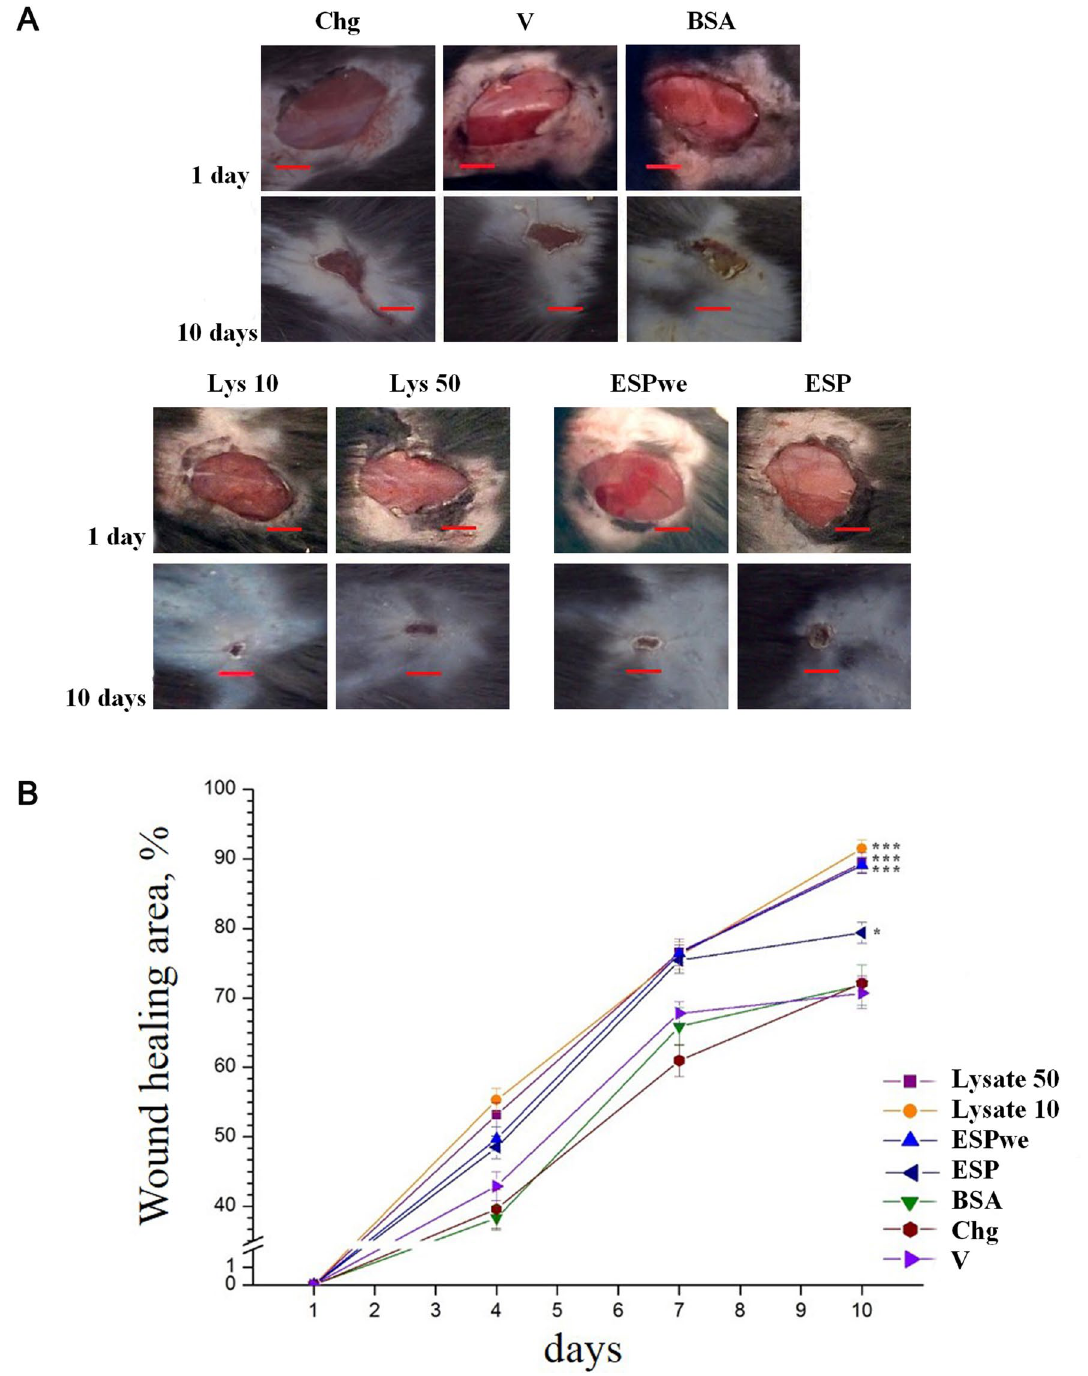
Figure 1. Visual scoring of wound healing. ( A ) Wound healing on days 1 and 10 after treatment. Wounded untreated, vehicle and nonspecific control and specific treatment groups (3 mm scale bar); ( B ) Wound healing rate chart. Data is presented for area percentage as mean ± SEM, *p < 0.05, ***p < 0.001 as compared to vehicle